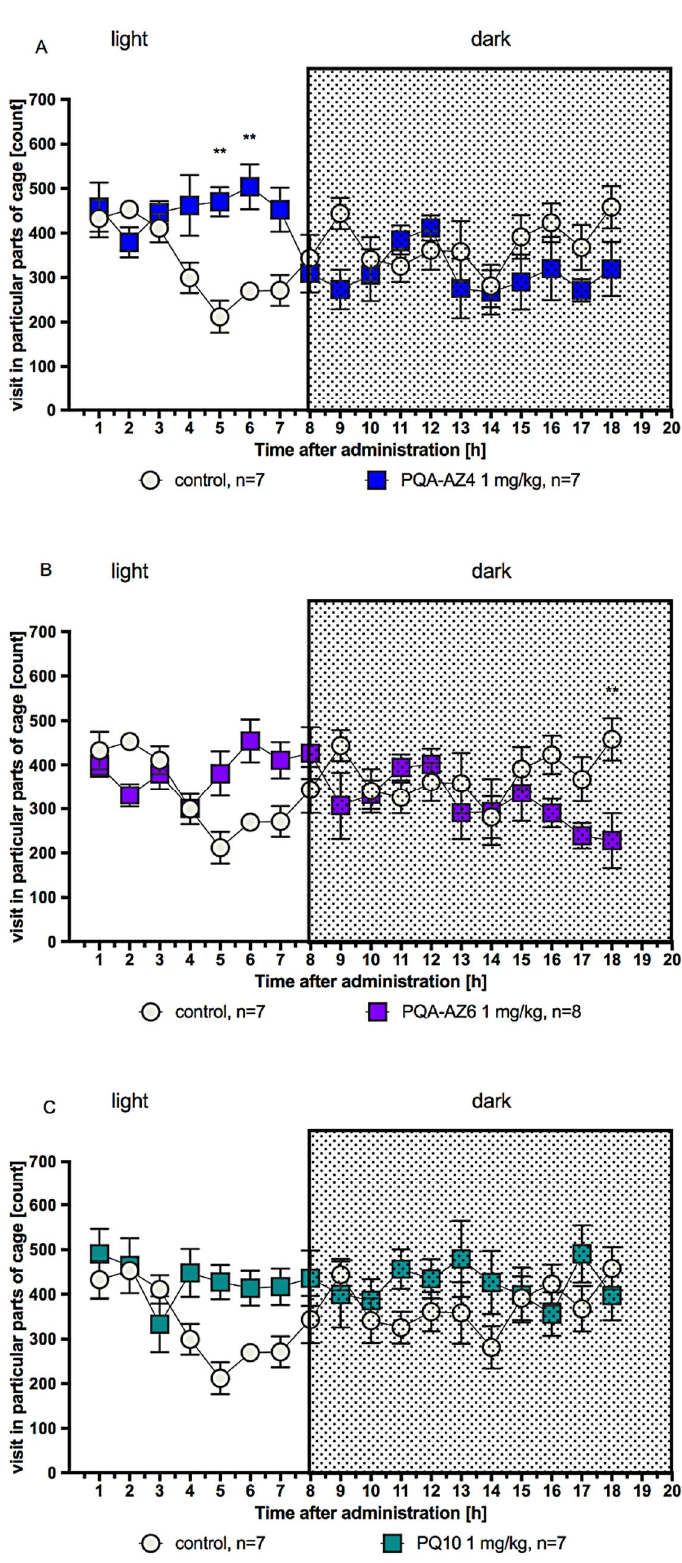
Figure 4. Effects of administration of PQA-AZ4, PQA-AZ6, or PQ10 on the spontaneous activity of rats during light and dark phases: ( A )—after the 20th administration of PQA-AZ4, ( B )—after the 20th administration of PQA-AZ6, ( C )—after the 20th administration of PQ10. Each plot represents the mean ± SEM, n = 7–8 rats per group; two-way ANOVA followed by Bonferroni’s post hoc test, ** p < 0.01 vs. respective vehicle-treated group.